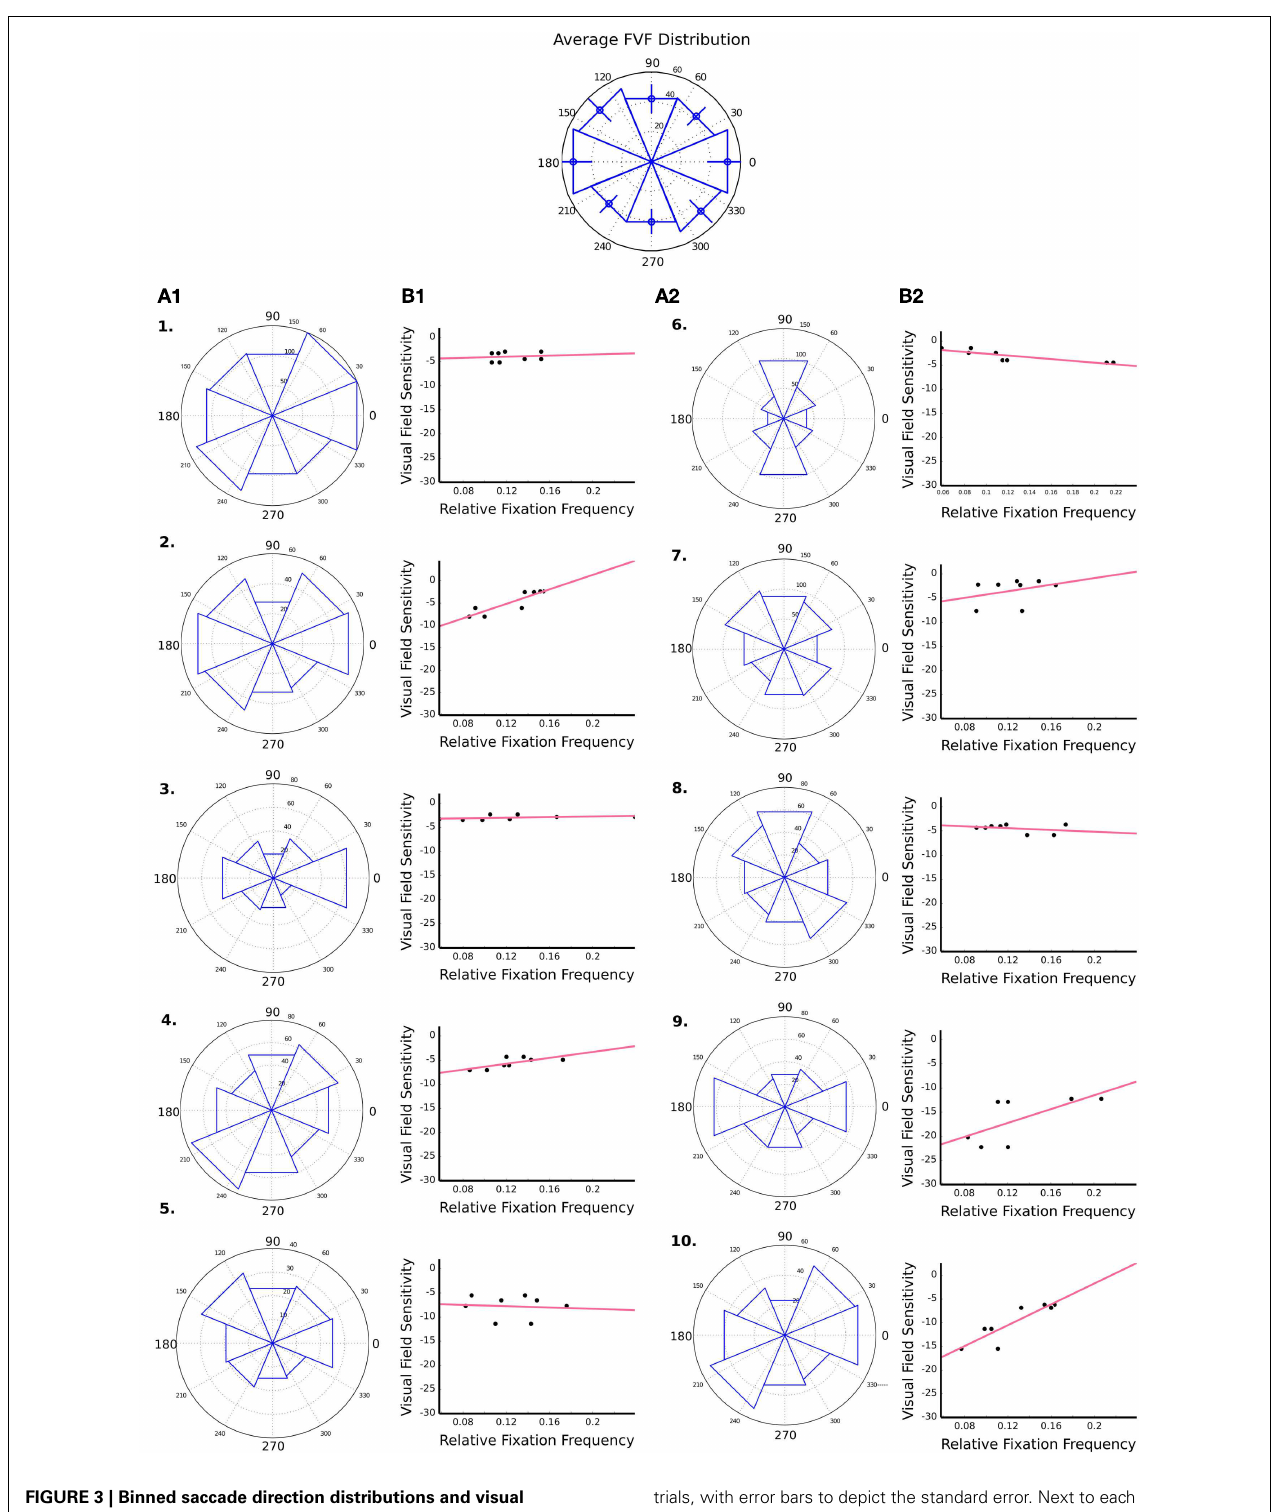
FIGURE 3 | Binned saccade direction distributions and visual field sensitivity. The Columns A1 and A2 depict angle histograms for the distribution of saccade directions over all trials for each of the 10 PVFL patients.The FVF group histogram is centered above and is representative of a mean distribution for all FVF participants over all